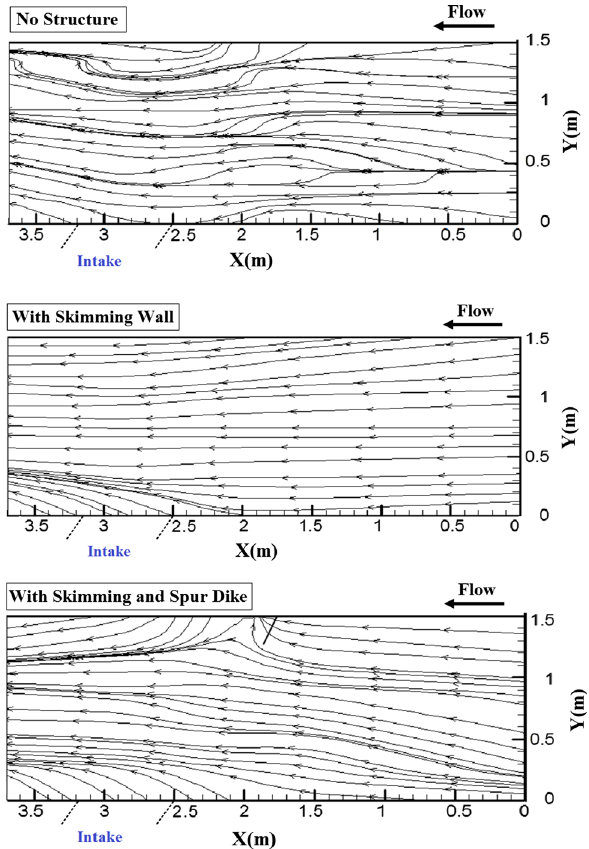
Fig. 14 Streamlines on the plan ( x – y